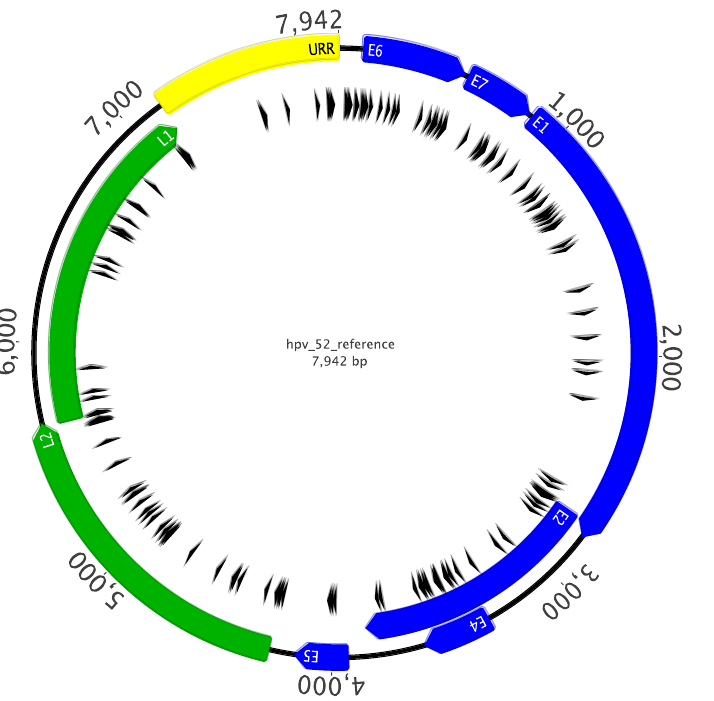
Figure 1. Distribution of CpG sites across HPV52 reference genome. The complete genomic sequence of the HPV52 genome (GenBank ID 397038) was extracted from the PaVE database (http://pave.niaid.nih.gov; accessed on 4 March 2021). CpG sites are marked with a black arrowhead. Early genes are shown in blue, late genes are shown in green, and the upstream regulatory region (URR) is shown in yellow. This image was created and annotated using Geneious v6.1.7 (http://geneious.com).